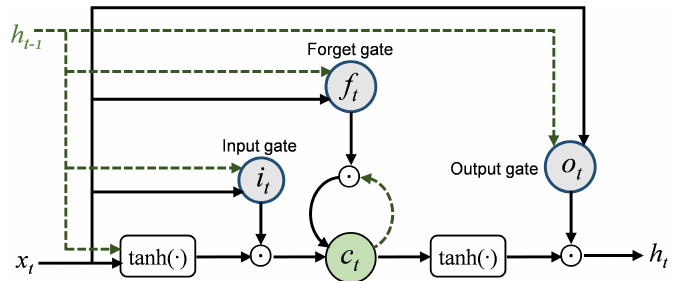
Figure 6. Diagram of an LSTM cell with its inner memory mechanism, including the input gate i t , forget gate f t , and output gate o t . The dashed line represents the information from the last time step. The output y T of LSTM would correspond to one point of the